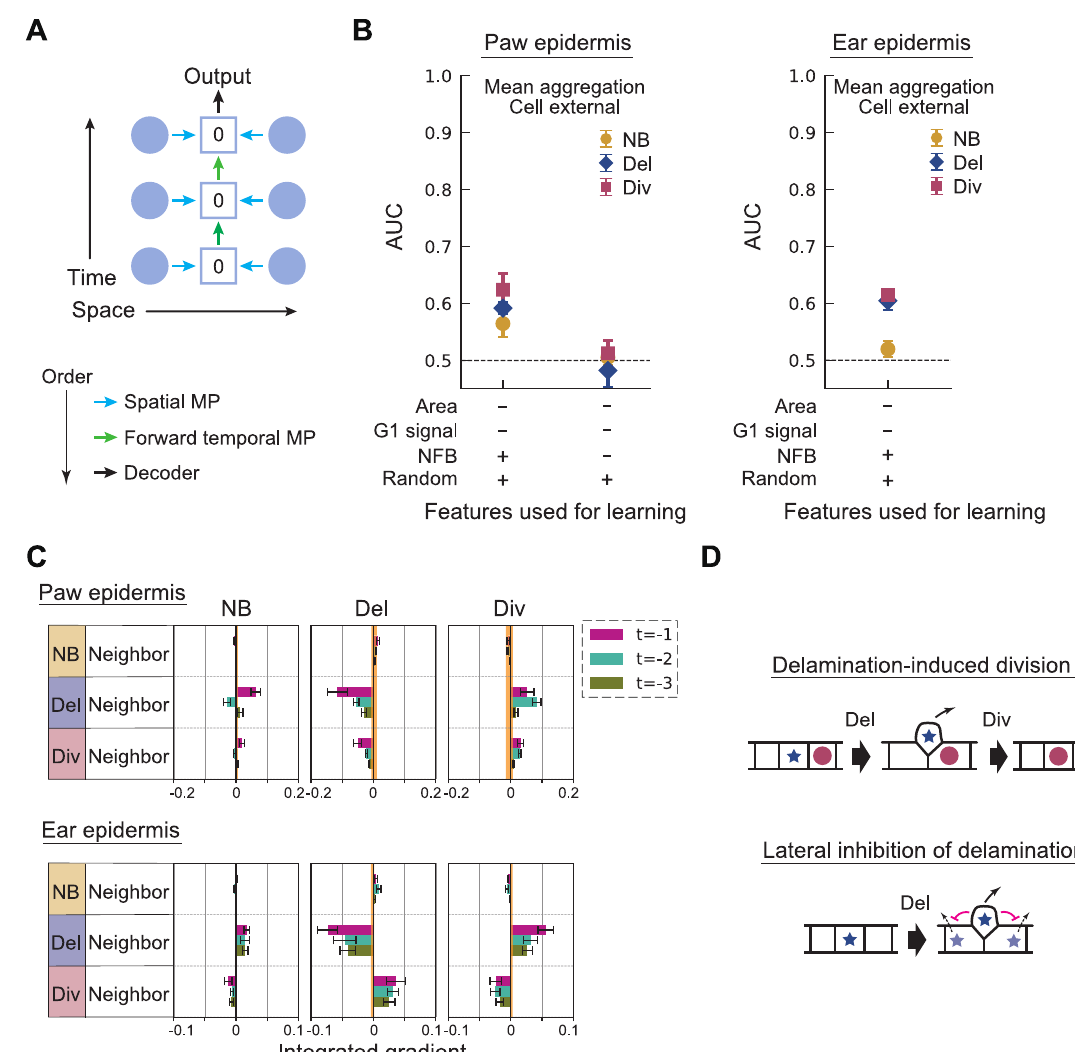
Fig 3. Cell external model with mean aggregation applied to hind paw and ear epidermis data. (A) Schematic of the information flow in the cell external model (see Fig 1D). The zero value in the target cell’s box represents the null feature vector, which is assigned to the target cell’s feature in the cell external model. (B) The AUC of the cell external model with mean aggregation is shown for models with and without future fate, obtained by averaging over six trained models (left: paw, right: ear). Error bar: standard deviation. (C) The attribution of the cell external model with mean aggregation is shown for the feature condition: (Area, G1 signal, NFB, Random) = ( − , − , +, +) (top: paw, bottom: ear). The IG averaged over six trained models is shown for each pooled feature. Error bar: standard error. The upper and lower values of the IG of the random feature are shown as the orange zone. (D) Schematic of a delamination-induced division and lateral inhibition of delamination by neighbor cell